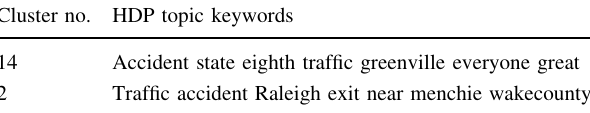
Table 6 Extracted topics by the hierarchical Dirichlet process (HDP) for traffic-related events during Hurricane Florence in North